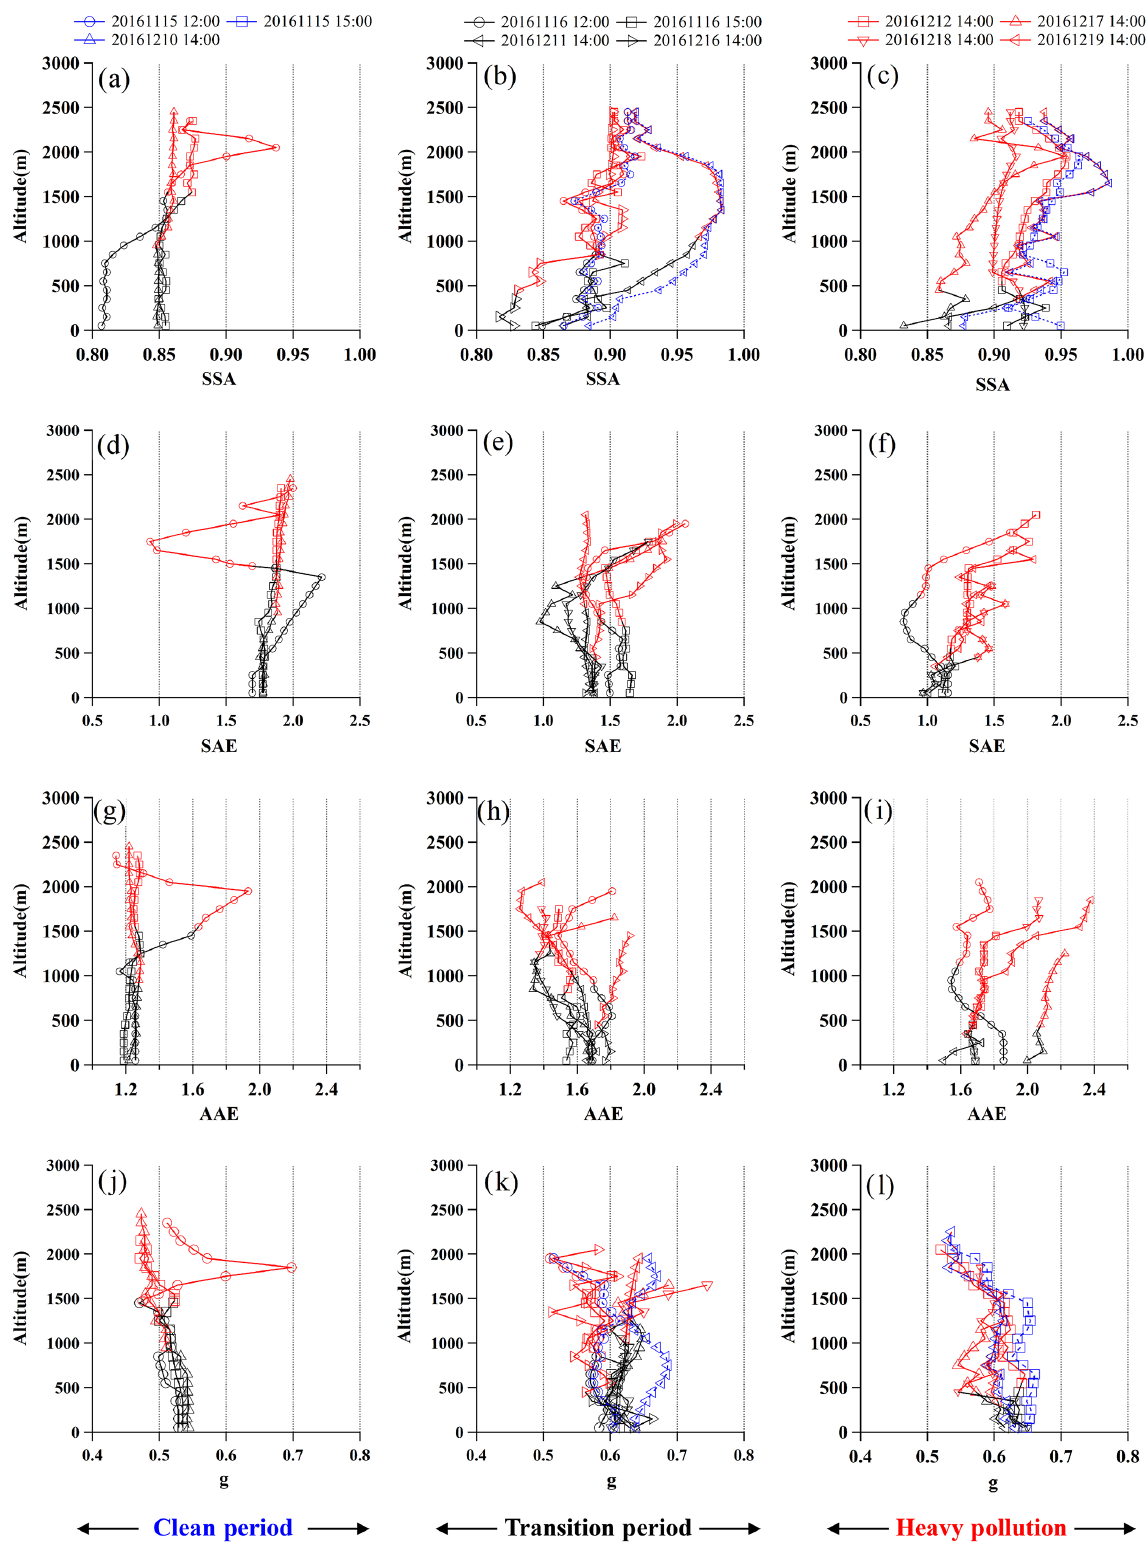
Figure 4. Vertical profiles of aerosol single-scattering albedo at 440nm (SSA; a–c ), scattering Ångström exponent (SAE; d–f ), absorption Ångström exponent (AAE; g–i ), and asymmetry parameter ( g , j–l ) for CP (a, d, g, j) , TP (b, e, h, k) and HP (c, f, i, l) , respectively. The hygroscopicity-corrected profiles were shown in blue